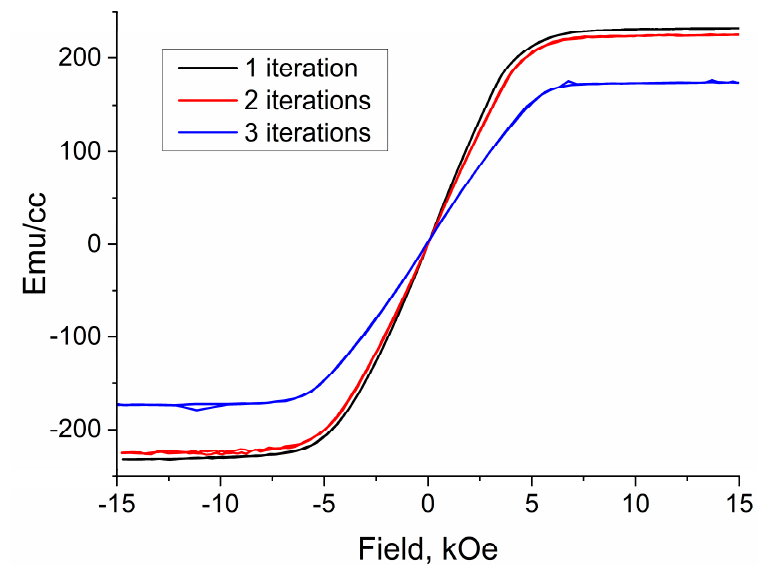
Figure 7. Magnetization curves in an iterative series of experiments.